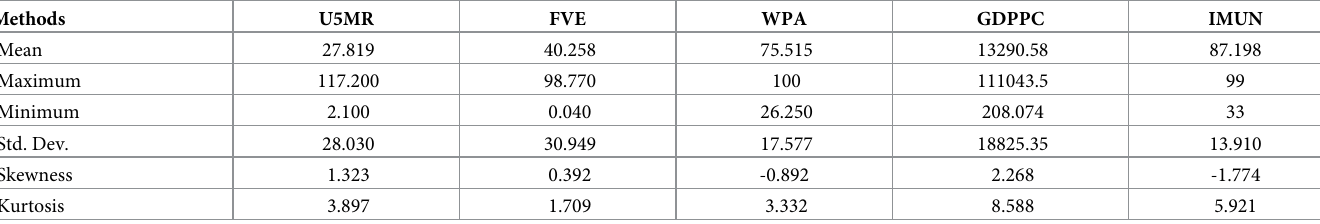
Table 2. Descriptive